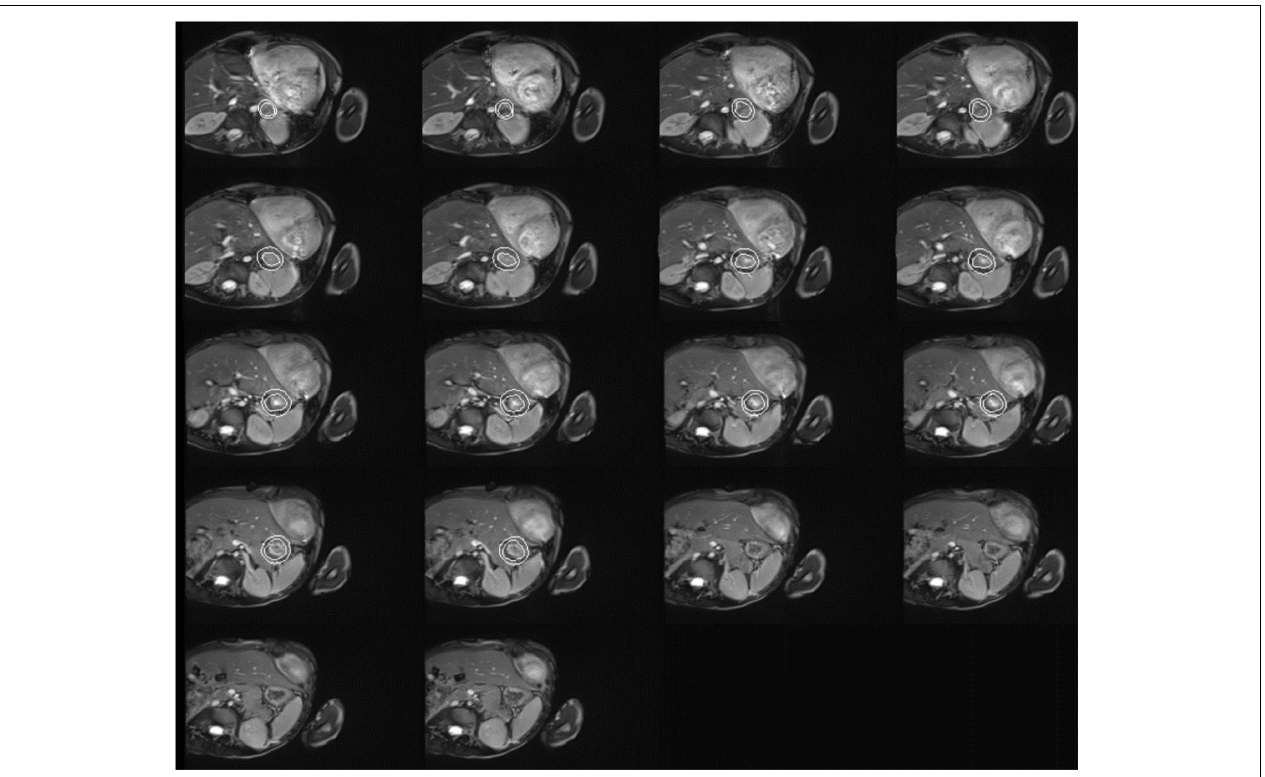
FIGURE 2 | Cardiac magnetic resonance imaging of the patient with both dyschromatosis symmetrica hereditaria (DSH) and Aicardi-Goutières syndrome type 6 (AGS 6). Cardiac MRI image indicated mitral valve stenosis (MS), severe mitral regurgitation (MR), tricuspid regurgitation (TR), biatrial enlargement with the more significant left atrium, biventricular hypertrophy, and a small amount of pericardial effusion